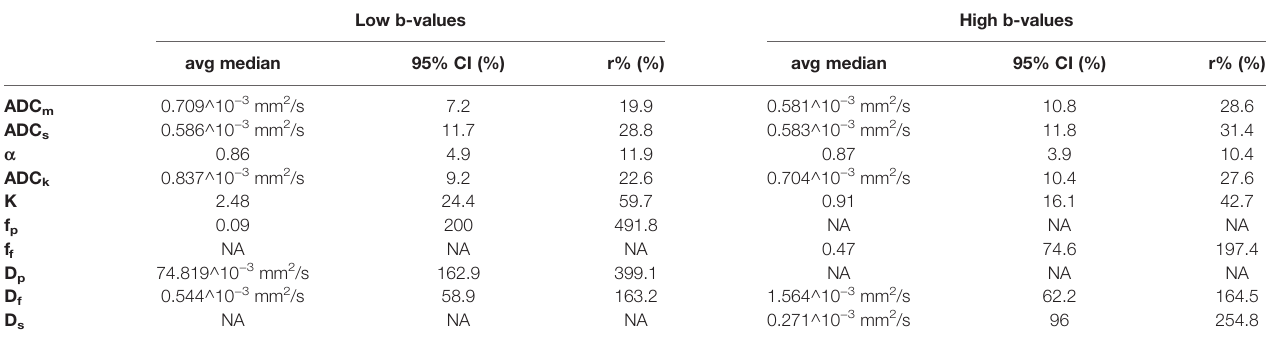
TABLE 3 | Repeatability of the fi tted parameters for DWI data obtained using low and high